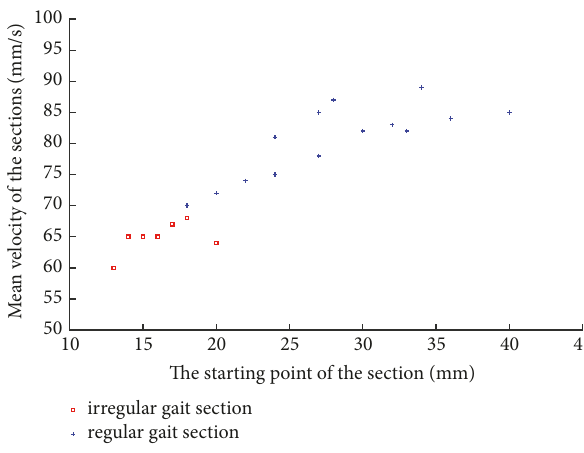
Figure 5: The mean velocity and the starting position of different gait